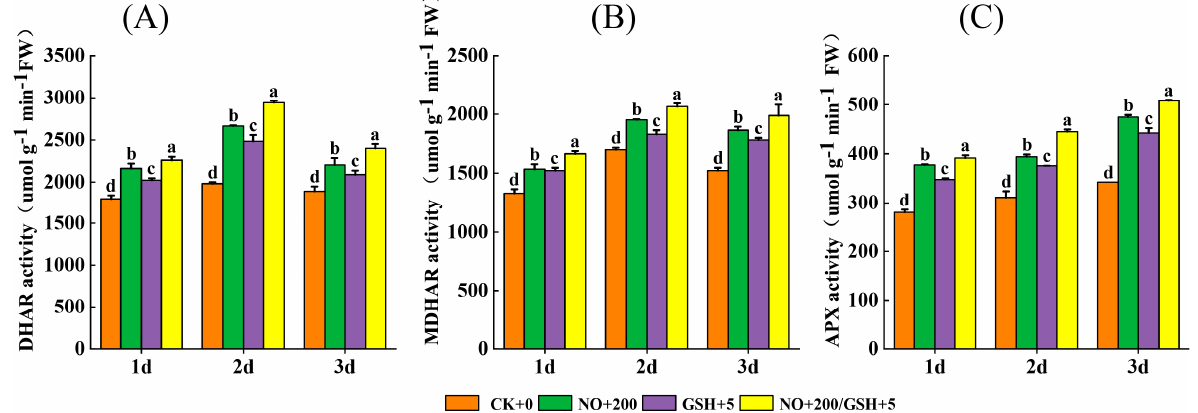
Figure 6. Effects of exogenous NO and GSH on the activities of (( A ): DHAR), (( B ): MDHAR), and (( C ): APX) in leaves of cowpea seedlings under low-temperature stress. Different letters indicate statistically significant differences according to Duncan's multiple range test at p < 0.05.